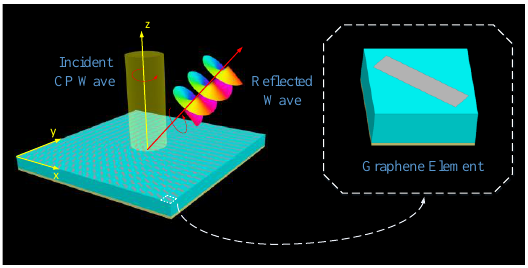
Figure 1. The scheme of the proposed multifunctional graphene metasurface. When a circularly polarized (CP) wave is normally incident, the metasurface can control the spin angular momentum (SAM) or/and orbital angular momentum (OAM) of the reflected wave. The inset shows the structure of a graphene element.